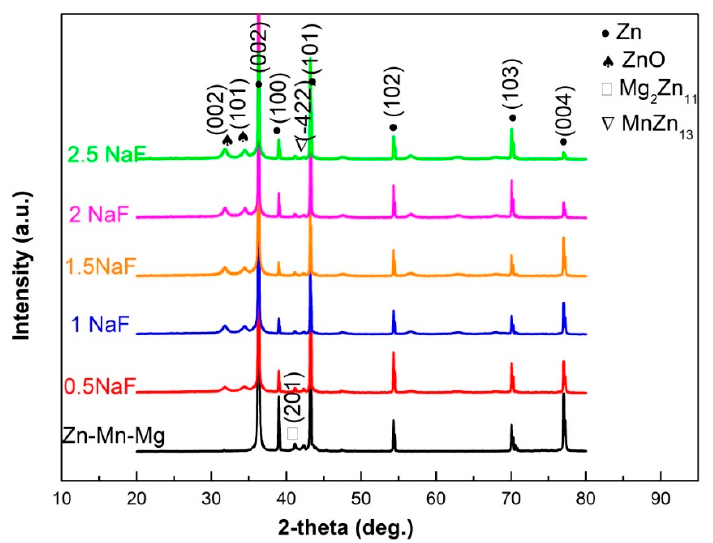
Figure 4. XRD patterns of MAO coating with different NaF concentrations from 0.5 g/L to 2.5 g/L.